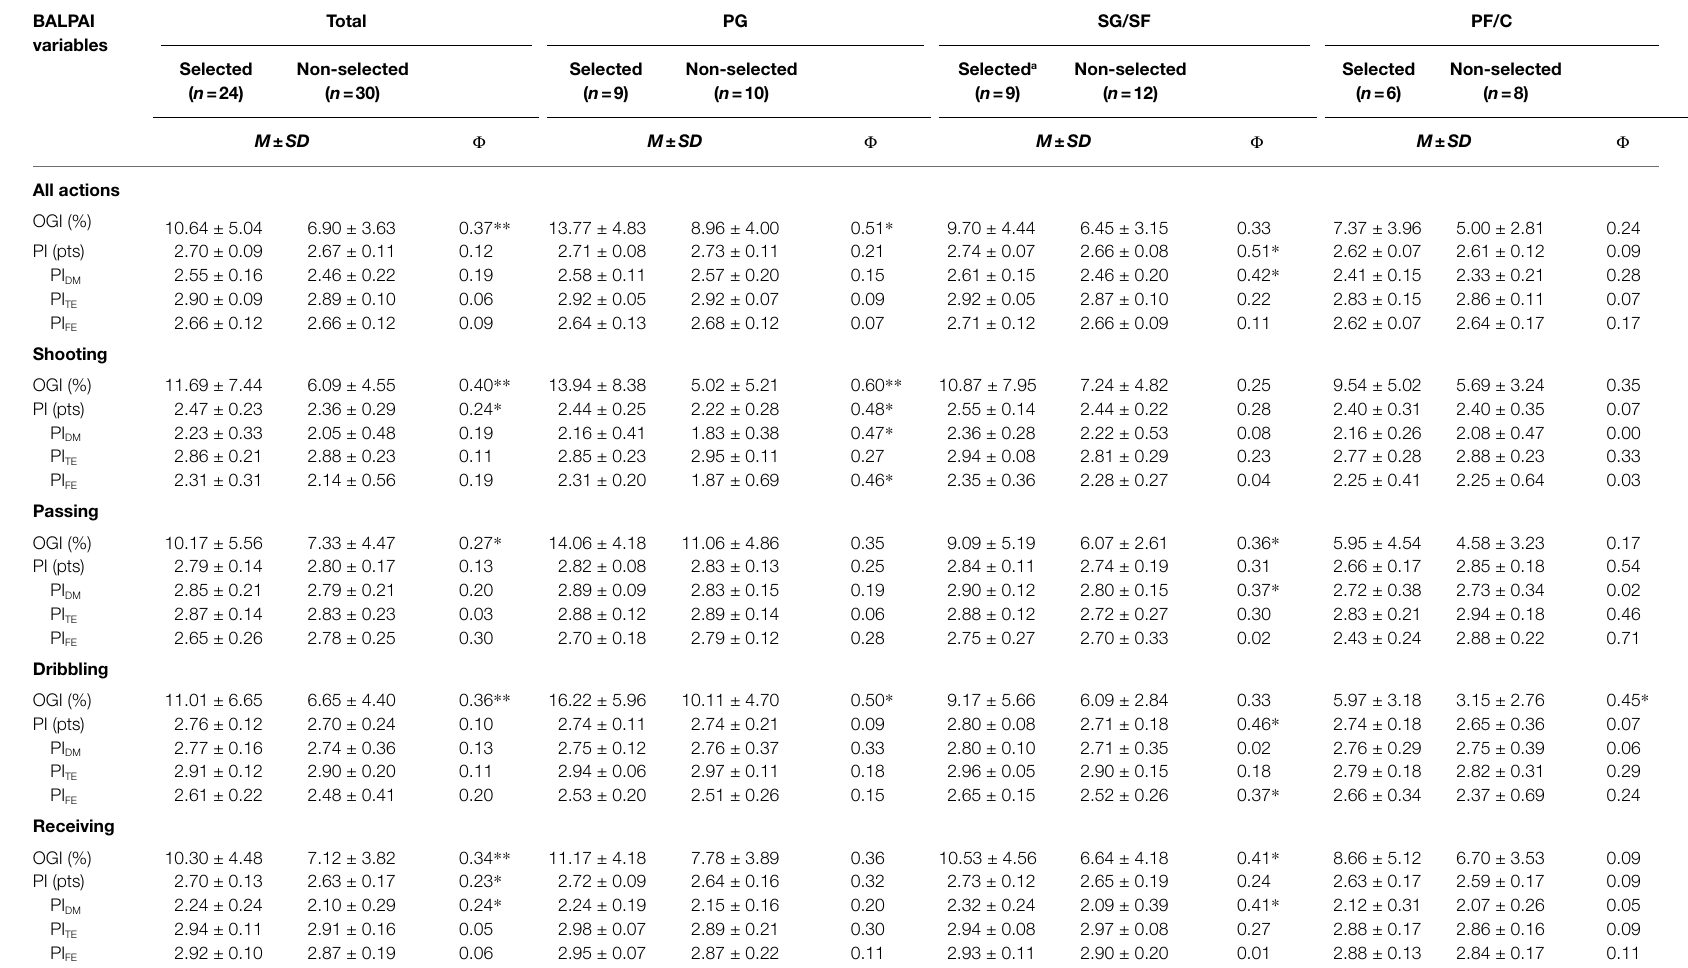
TABLE 2 | Descriptive statistics and effect sizes for BALPAI variables separated by selection status and playing position. BALPAI